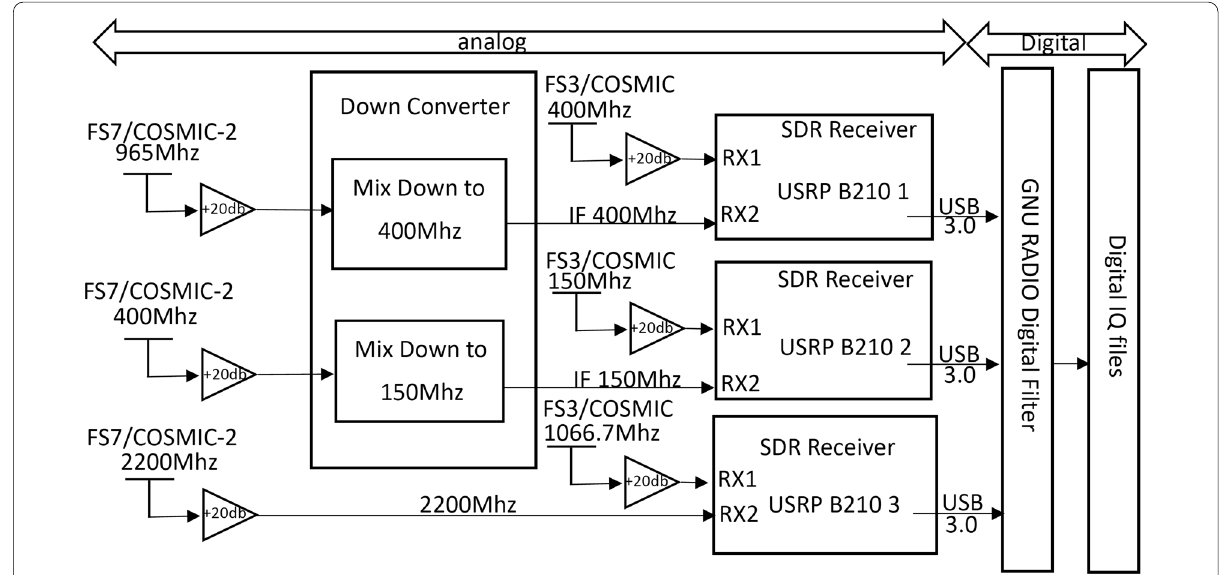
Fig. 1 Block diagram of the beacon receiver